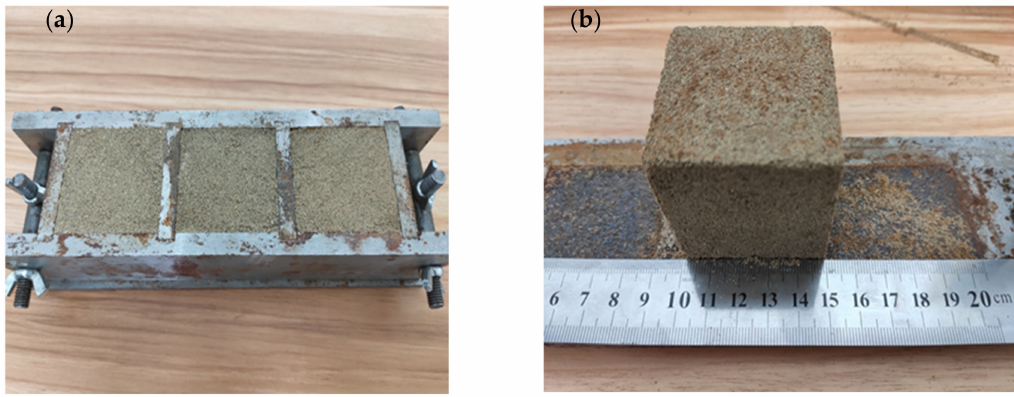
Figure 2. Preparation samples for experimental test (( a ): sample mold; ( b ): sample